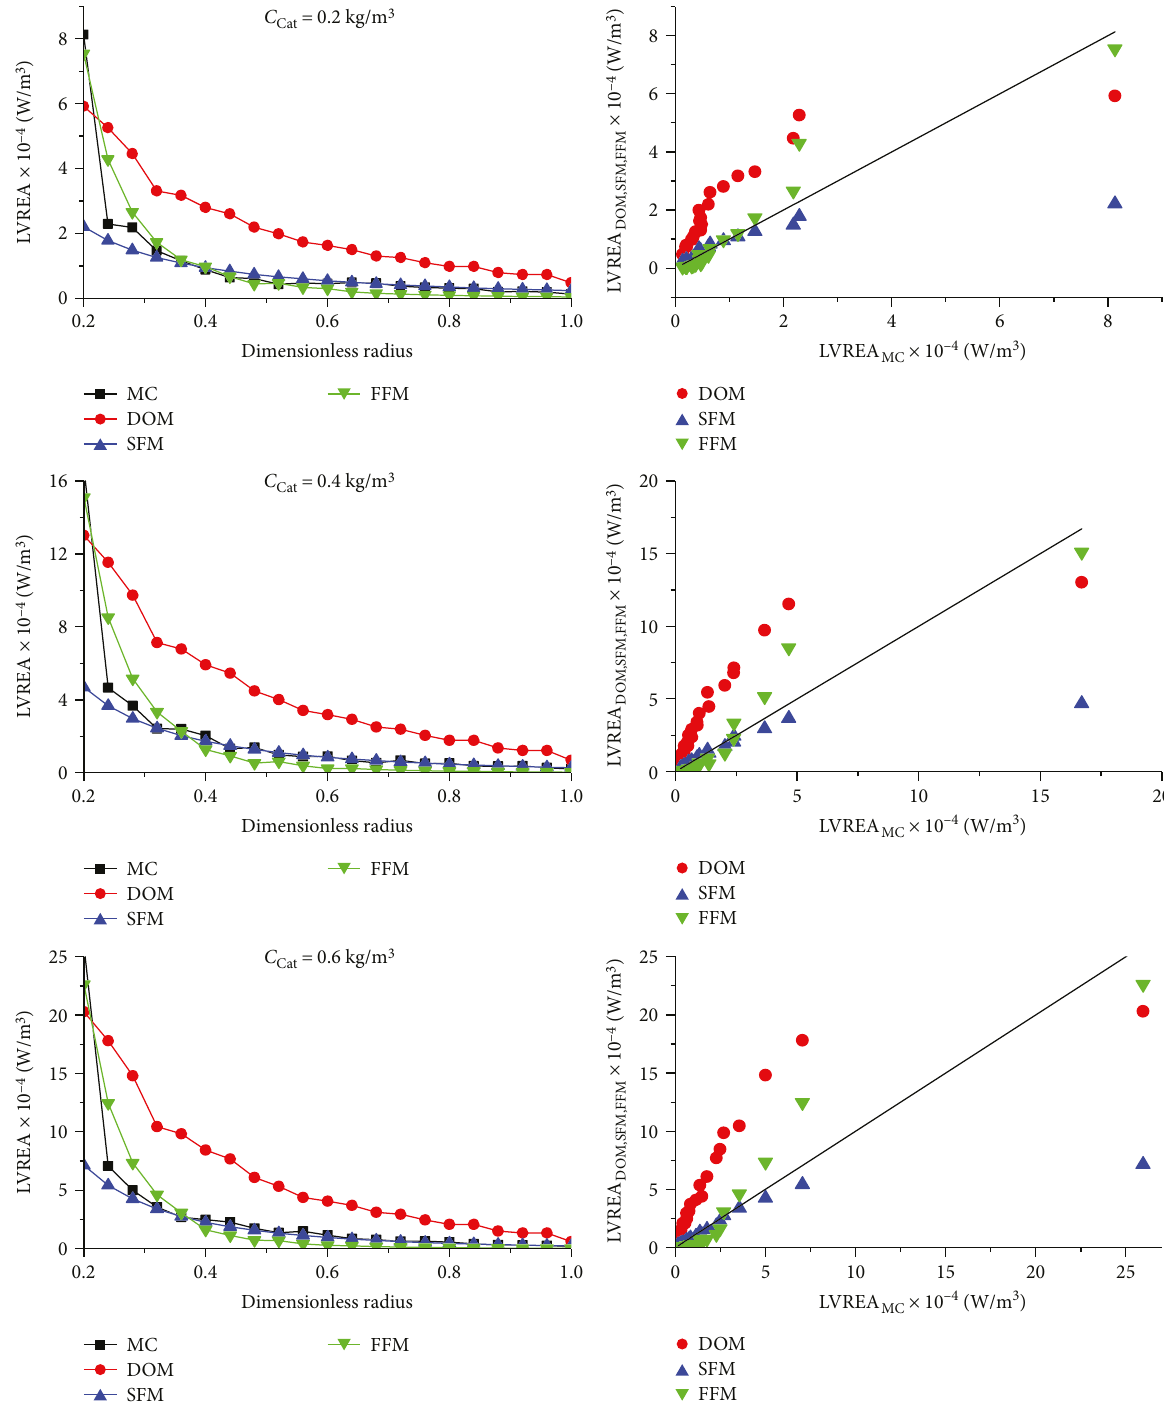
Figure 8: Radial pro fi les of local volumetric rate energy absorption (LVREA) obtained by four- fl ux model at di ff erent concentration of ) for system 2 and its comparison with the other catalyst (LiVMoO 6